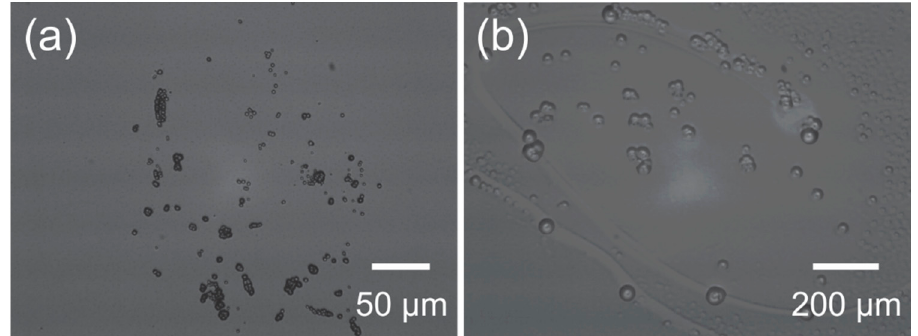
Figure 11. ( a ) Deposited Parylene layer incorporating spherules which results in a cloudy in appearance when observed by eye; and ( b ) magnified photograph revealing the presence of small clusters of spherules.